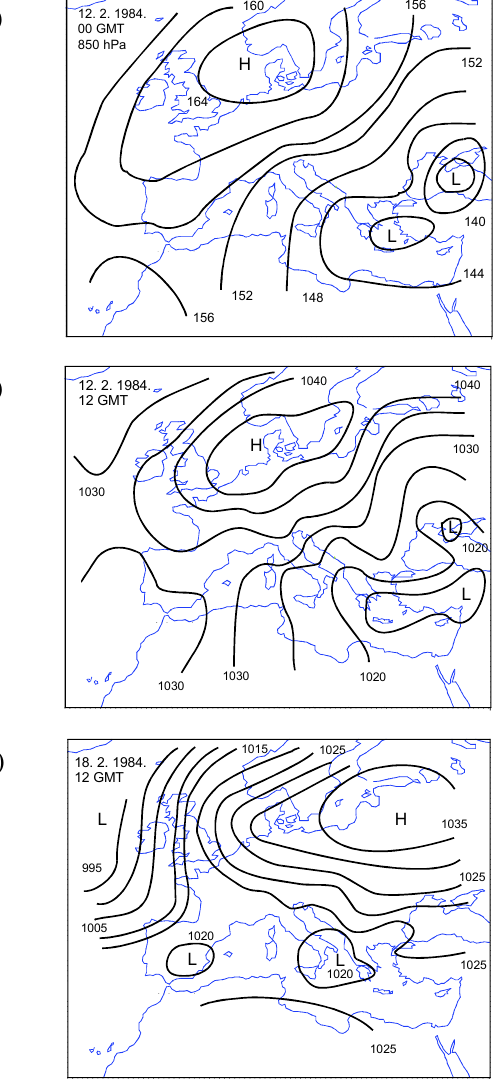
Fig. 7. Absolute topography AT 850hPa on 12 February 1984 ( a ) , surface air pressure field on 12 February 1984 ( b ) , and surface air pressure field on 18 February 1984 ( c )